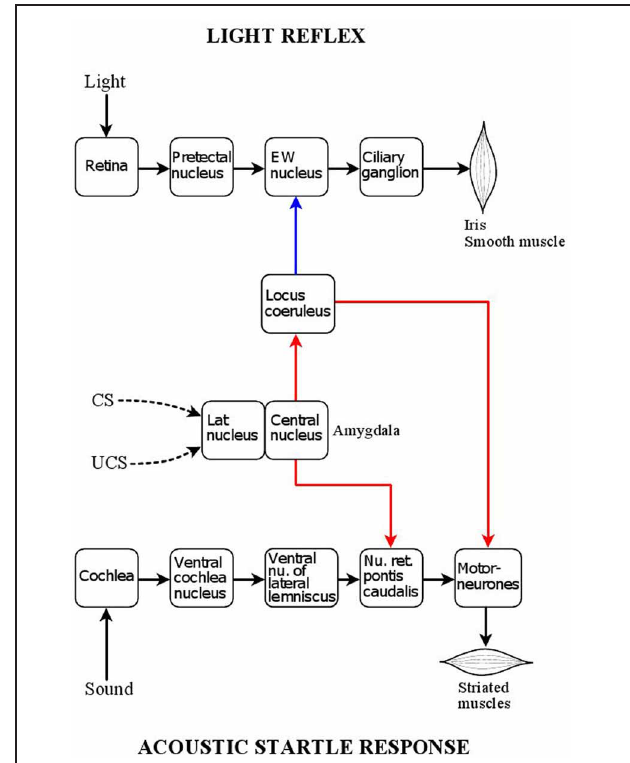
FIGURE 1 | Central position of the locus coeruleus in relation to the acoustic startle reflex and pupillary light reflex pathways. Red: excitatory connections; blue: inhibitory connections. The acoustic startle response is triggered by a sound stimulus activating auditory receptors in the cochlea. Auditory signals are transmitted via two nuclei of auditory processing, the ventral cochlear nucleus and ventral nucleus of the lateral lemniscus, to a relay nucleus in the pontine reticular formation, nucleus reticularis pontis caudalis, which projects directly to bulbar and spinal motoneurones. The startle response consists of the sudden synchronized contraction of a large array of facial and skeletal muscles. The locus coeruleus has a facilitatory influence on the motor neurones via an excitatory noradrenergic output involving the stimulation of α 1 -adrenoceptors. Painful stimuli, via activation of the locus coeruleus can enhance the acoustic startle response (“sensitization”). The reflex response can also be enhanced by fear-conditioning via the amygdala. The lateral nucleus of the amygdala processes the association between aversive (painful) unconditioned (UCS) stimuli and neutral (e.g., light) conditioned (CS) stimuli, and the arising conditioned fear signal is transmitted, via the central nucleus of the amygdala, to the nucleus reticularis pontis caudalis, leading to the enhancement of the reflex response (“fear-potentiation”). The amygdala also projects to the locus coeruleus, whose activation by conditioned fear contributes to the fear-potentiation of the acoustic startle response. The pupillary light reflex is a parasympathetic autonomic reflex. Light signals stimulate photoreceptors in the retina which project, via melanopsin-containing intrinsically photosensitive retinal ganglion cells (ipRGCs), to the pretectal nucleus, a parasympathetic premotor nucleus: this leads to activation of the reflex pathway via the chain Edinger Westphal nucleus (preganglionic neurones) → ciliary ganglion (postganlionic neurones). The reflex response is the contraction of the smooth muscle fibres of the sphincter pupillae muscle, leading to pupil constriction (miosis). The locus coeruleus has inhibitory influence on the preganglionic neurones via a noradrenergic projection involving α 2 -adrenoceptors. As the locus coeruleus can be activated by the amygdala, it transmits conditioned fear signals to the Edinger Westphal nucleus, leading to the attenuation of the light reflex response by conditioned fear